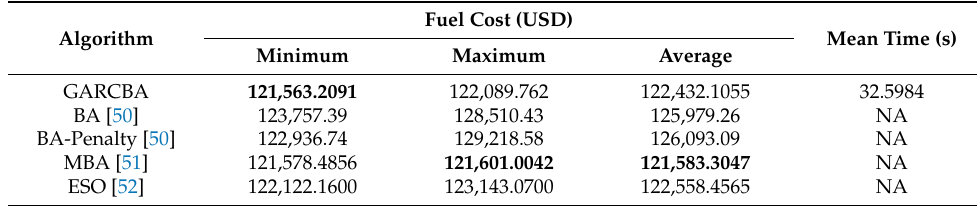
Table 10. Statistical results for Case